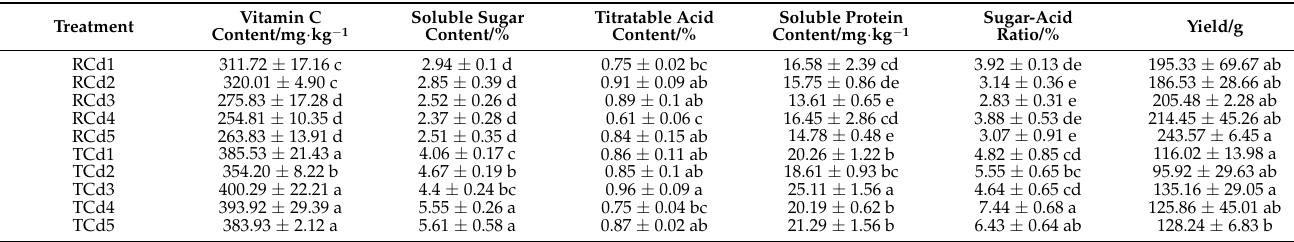
Table 4. Effect of different treatment on tomato